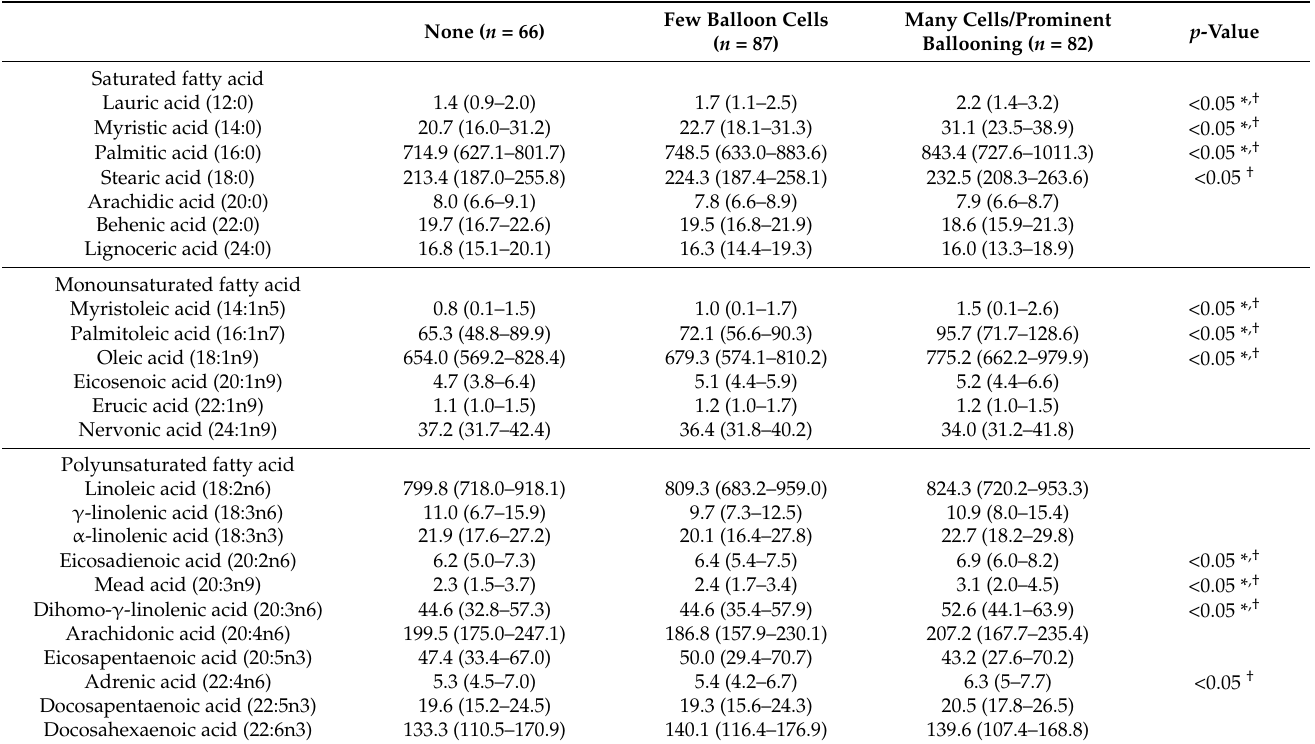
Table 9. Plasma fatty acid composition ( µ g/mL)